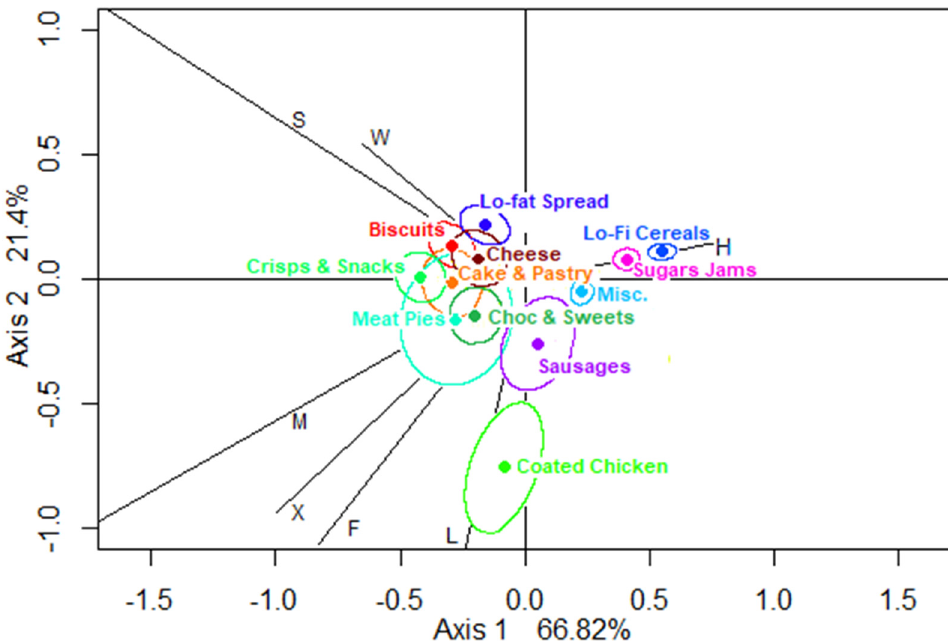
Figure 3. Biplot of locations showing confidence regions for less ‐ healthy food groups (using CABOOTCRS). Legend: H—home, S—school, W—work, F—friends’/carers’ homes, L—leisure, M—mobile, and X—other.